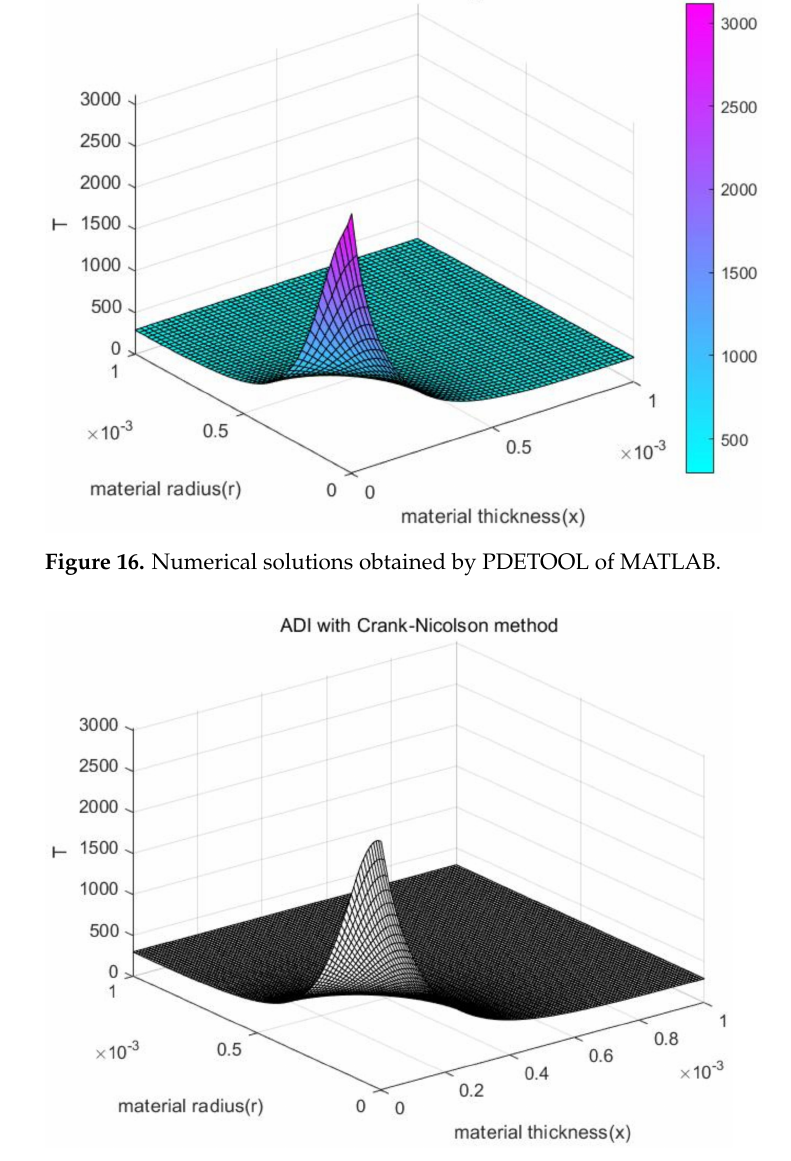
Figure 17. Numerical solutions of difference equations ( h = 0.001 / 100, τ = 0.01 / 500, H = 1.5 )